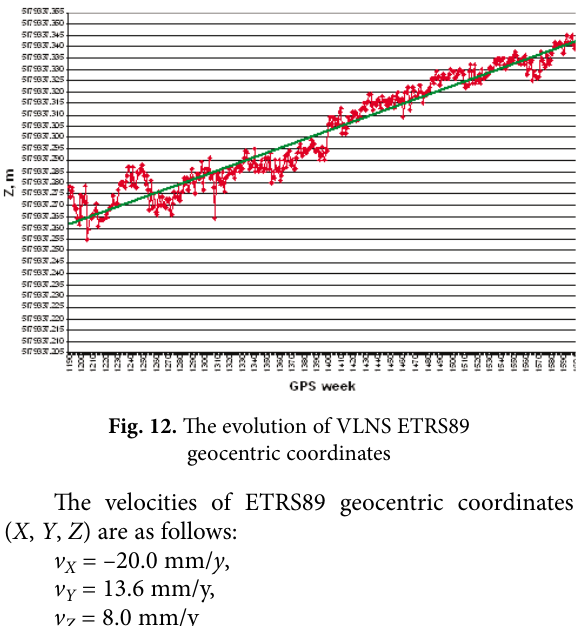
Fig. 11. The evolution of VLNS ETRS89 geocentric coordinates